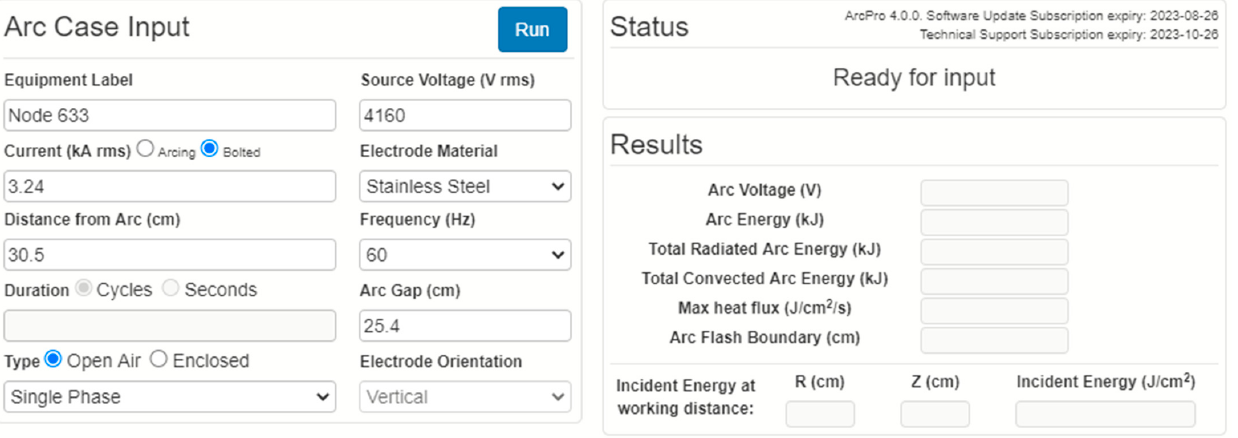
Figure 3. Phase-to-earth short circuit occurrence point—Case study 1.